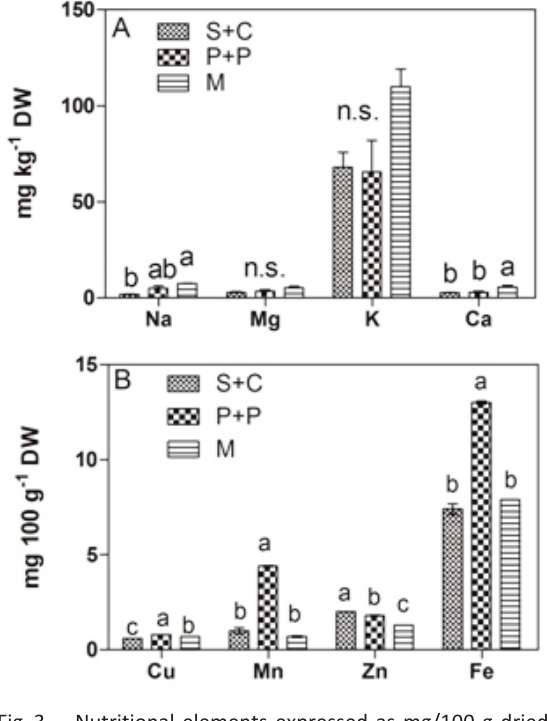
Fig. 3 - Nutritional elements expressed as mg/100 g dried wei- ght. A) Na, Mg, K and Ca. B) Cu, Mn, Zn and Fe in tomato fruits harvested from plants grown in sand and coir (S+C), peat and perlite (P+P) or purchased at the local market (M Values are means with standard errors. Data were subjected to two-way ANOVA analysis and diffe- rences among means were determined using Bonferroni’s post-test. Different letters indicate statisti- cal differences for <0.05. The heavy metals in fruits were under the safety thresholds established by the European